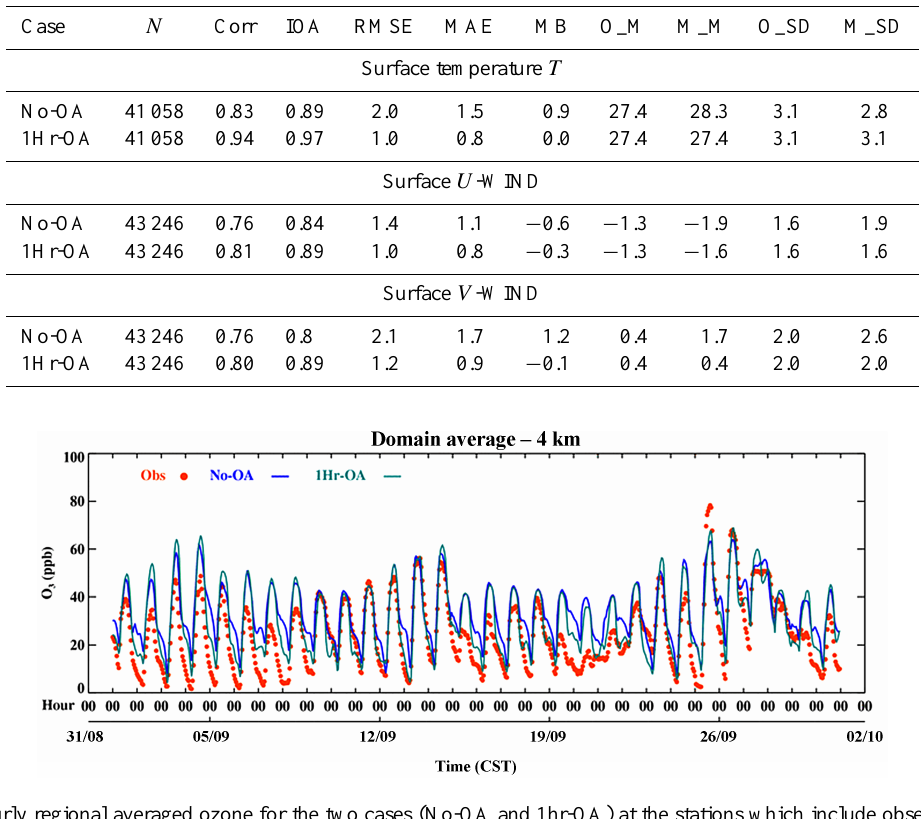
Figure 4. The hourly regional averaged ozone for the two cases (No-OA and 1hr-OA) at the stations which include observation surface O 3 over the 4km domain for September of